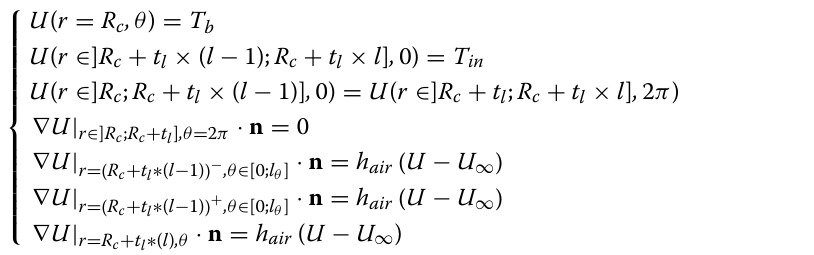
of the temperature between ply l at θ = 2 π and ply l − 1 at θ = 0. The tip of the very first layer is considered adiabatic. The boundary conditions are reviewed in Eq.